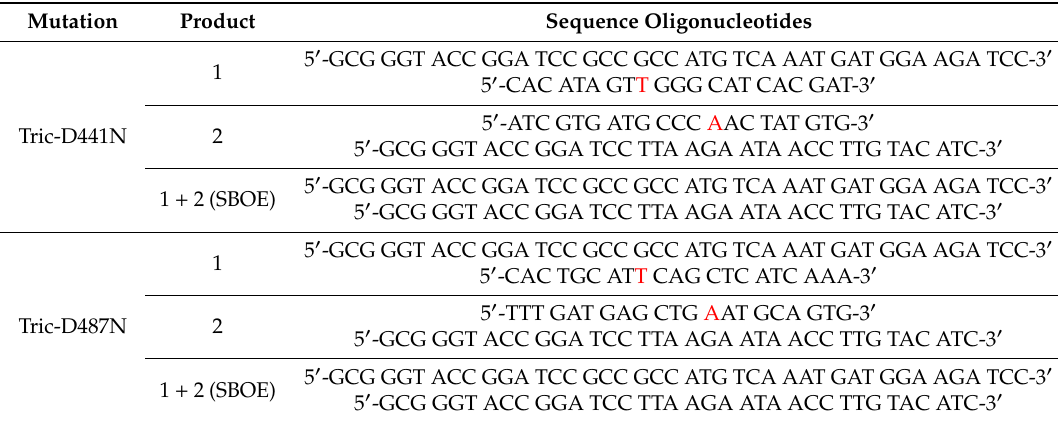
Table2. Sequencesofoligonucleotidesusedtogeneratemutatedtricellulinconstructs. Thebasesmarked in red represent those bases that di ff er from the wild-type sequence to generate the indicated mutations. Mutation